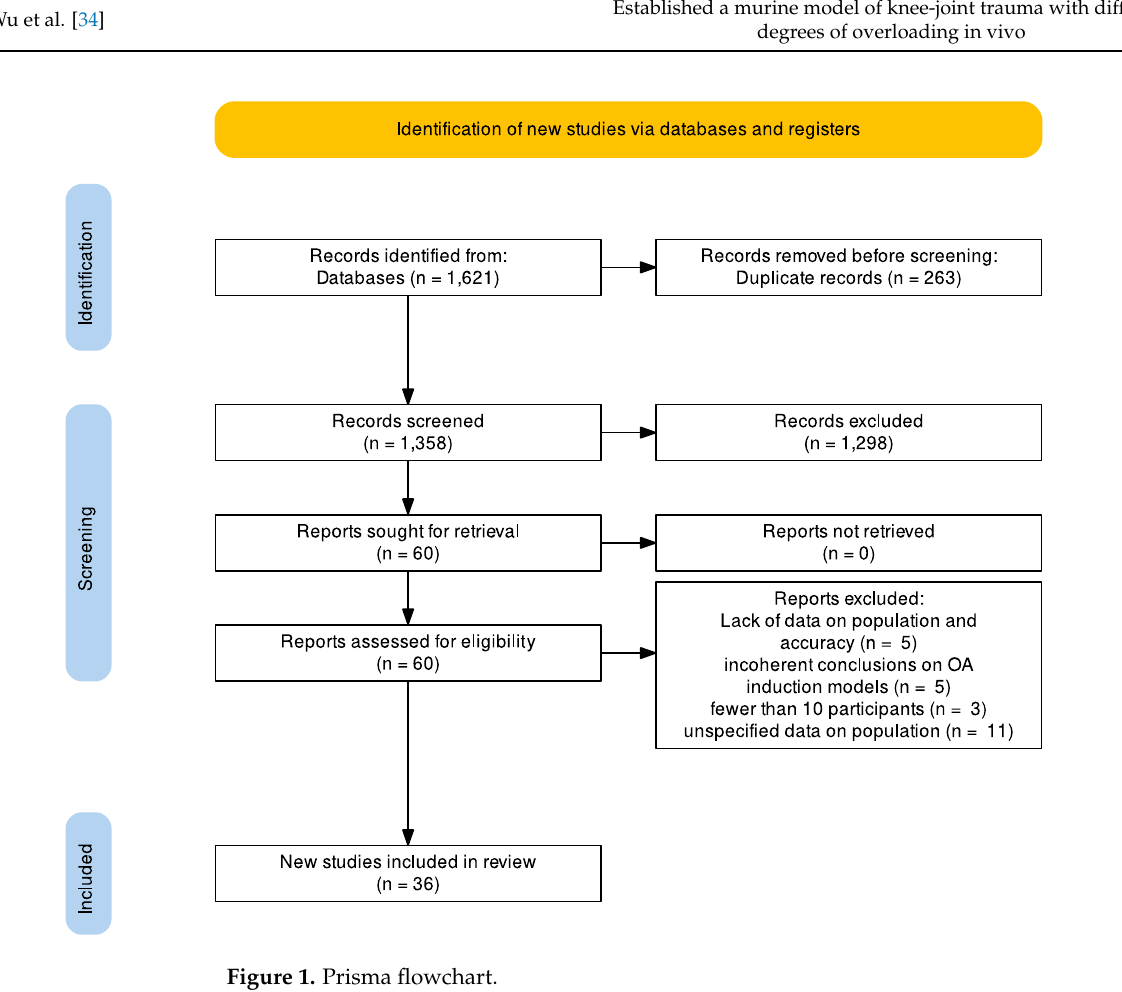
Figure 1. Prisma flowchart .